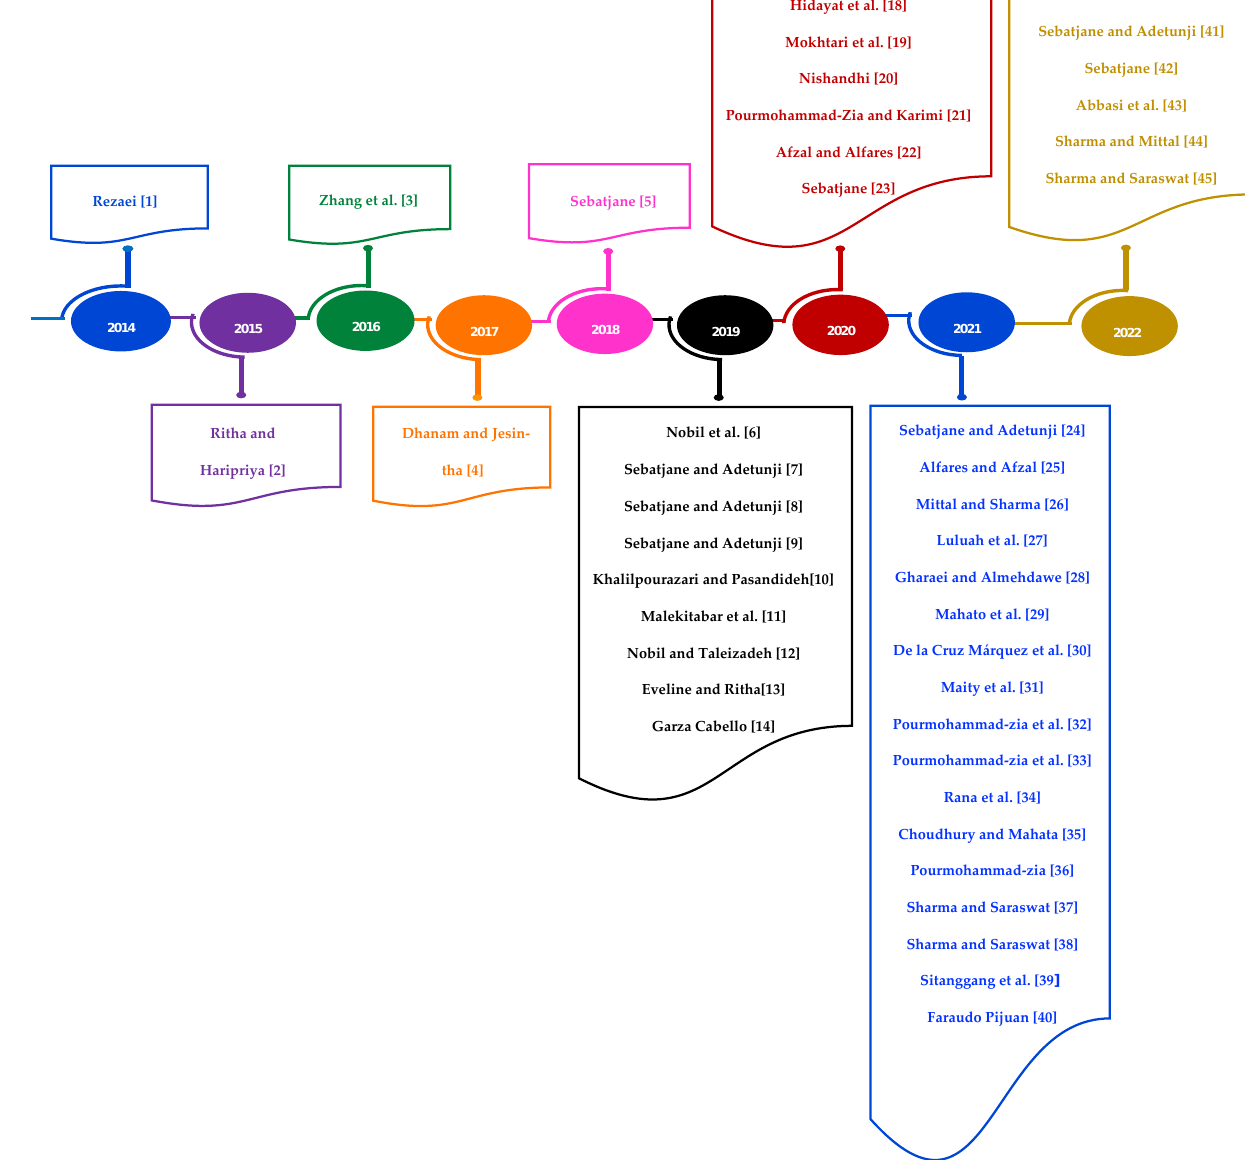
Figure 1. Inventory models with growing items.